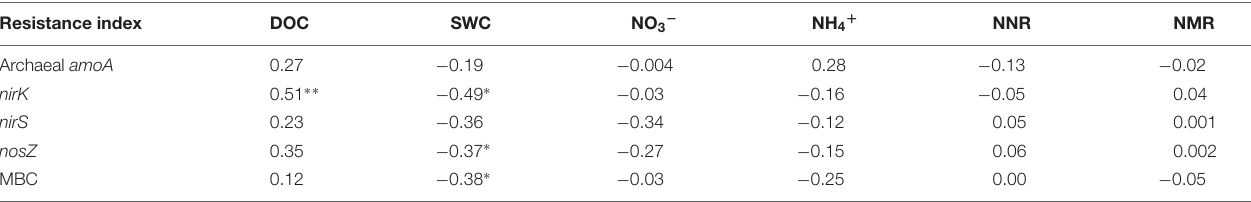
TABLE 2 | Spearman’s correlation ( r ) between the resistance indices of microbial attributes and soil physicochemical properties with significant levels at ∗∗ p < 0.01, ∗ p < 0.05. Resistance